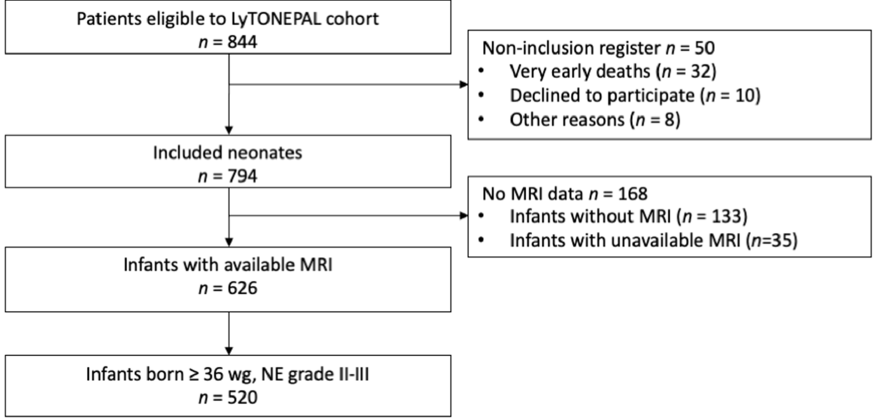
Figure 1. Flowchart. Abbreviations: WG = weeks’ gestational, NE = neonatal encephalopathy, grade I–II–III = stage of encephalopathy according to Sarnat classification [14], D = day. Characteristics of the population are presented in Table 1. Table 1. Characteristics of the population.